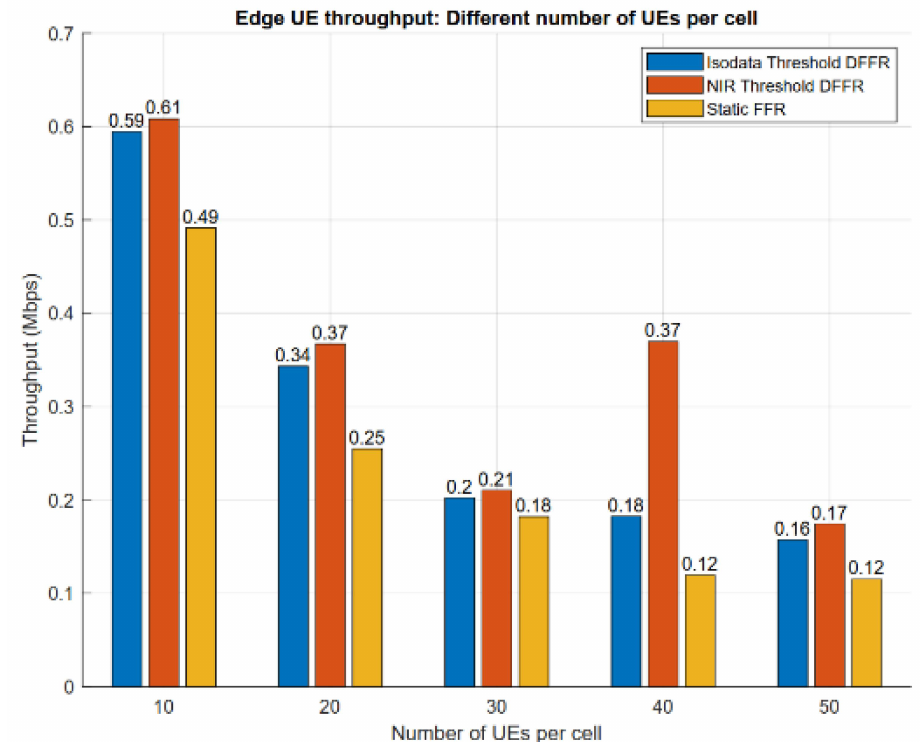
Figure 12. Peak edge throughput for a number of user equipment per